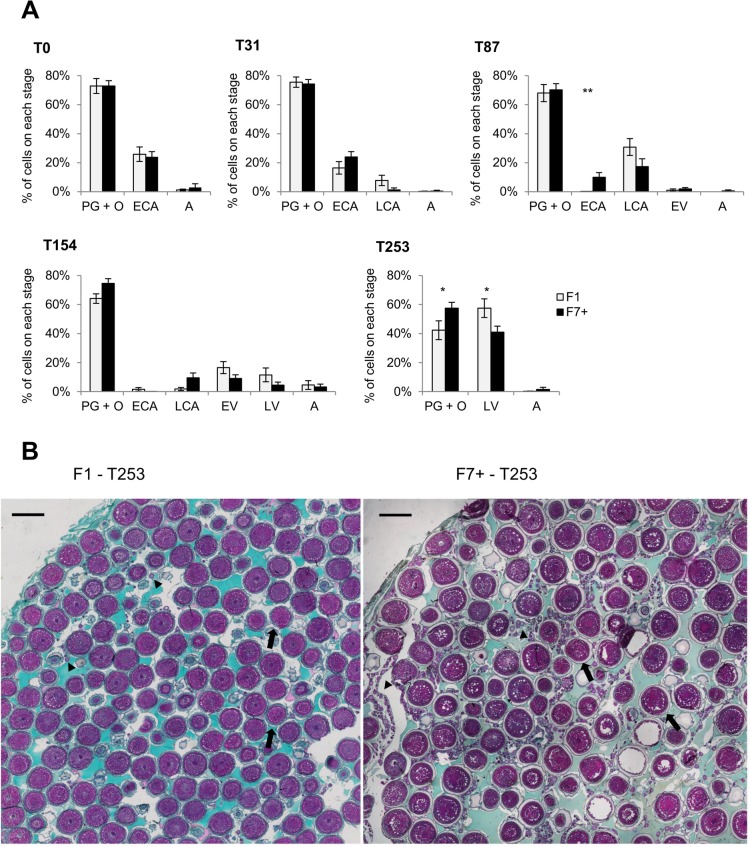
Histological follow up of the oogenesis progression.(A) Percentage of each cellular stage in gonads belonging to F7+ and F1 populations during oogenesis period. Stages are represented as: primary growth and oogonia—PG+O, early cortical alveoli—ECA, late cortical alveoli stage—LCA, early vitellogenesis—EV, late vitellogenesis—LV and atresia—A. Differences between the two populations were tested using non-parametric Wilcoxon-Mann-Whitney test (p<0.05). Significance levels are represented as follows: *, p = 0.05–0.01; **, p = 0.01–0.001; ***, p = 0.001–0.0001; and ****, p < 0.0001. (B) Histological section of gonads representative of F7+ and F1 ovaries at T253. Arrows points to LV stages and arrowheads indicate the PG+O stages. Scale bars represent 1000 μm.